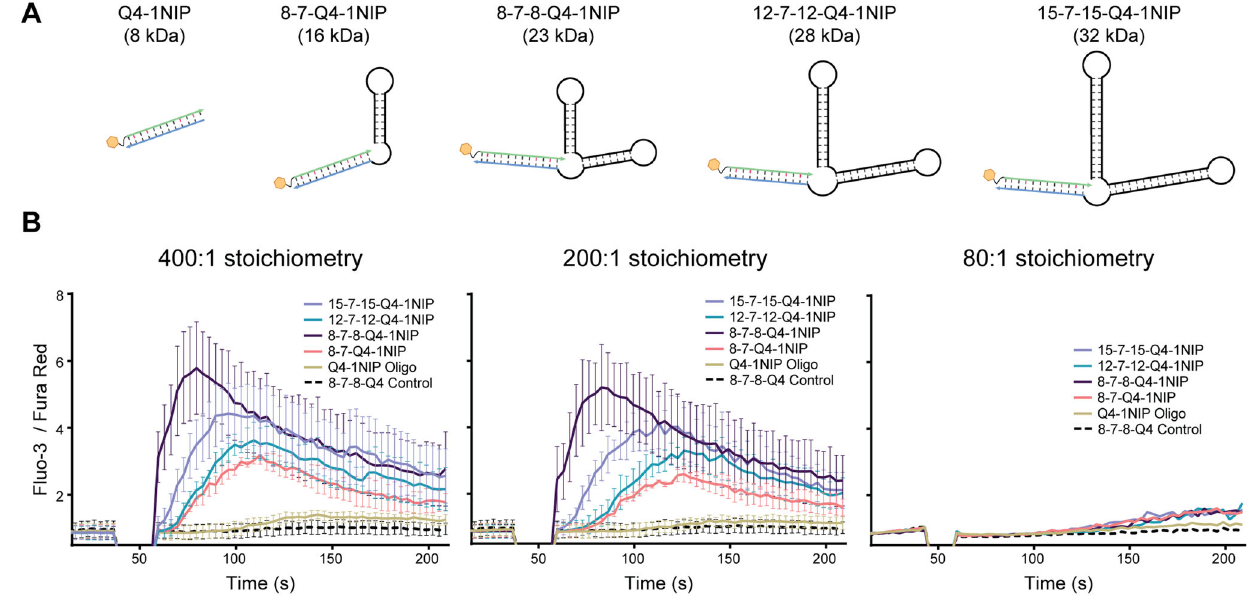
Fig. 7 | Activation ofB1-8iB cellswithdumbbell-Q4-1NIP constructs versusQ4- 1NIP alone. A Structures of the 4 dumbbell structure variants assembled with Q4- 1NIP. B Calcium fl uxofB1-8icellsuponstimulationwiththe4dumbbellconstructs,